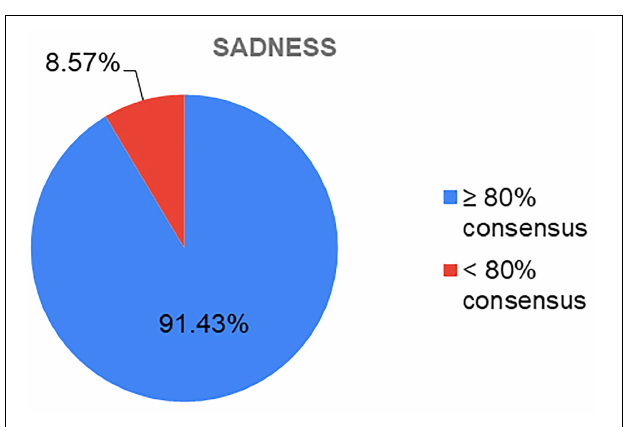
FIGURE 9 | Consensus percentages obtained for the emotions of